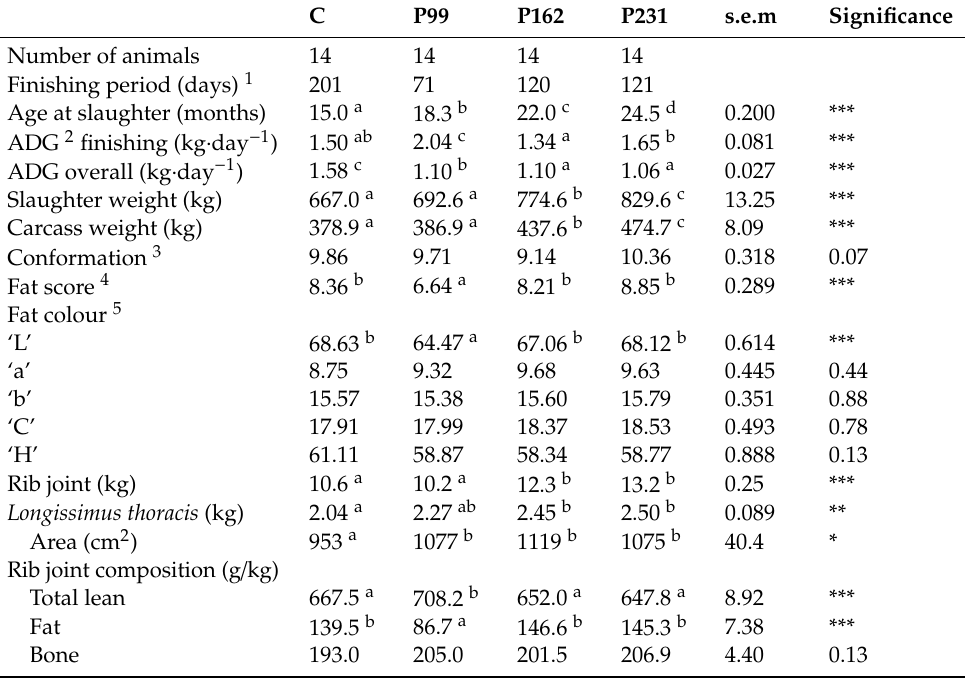
Figure 1. Growth pattern of bulls raised on either a concentrate-based system (C) or pasture-based systems (P) incorporating 99 days (P1), 162 days (P2) or 231 days (P3) of grazing period prior to indoor finishing on a concentrate-based diet ( n = 14 / treatment). Table 1. Production and carcass traits of bulls raised on either a concentrate-based system (C) or pasture-based systems incorporating 99 days (P99), 162 days (P162) or 231 days (P231) grazing prior to indoor finishing on a concentrate-based